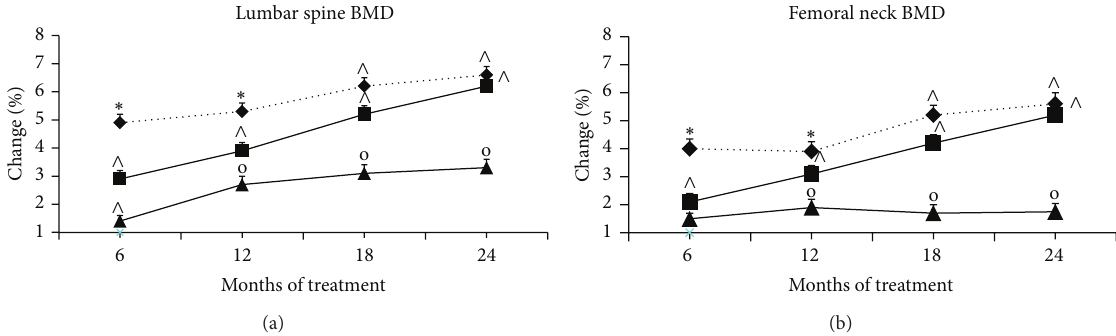
Figure 1: Changes in lumbar spine and femoral neck BMD throughout 24 months of treatment. Note: data are means ± SD. BMD: bone mineral density; ∗ : 𝑃 < 0.05 versus baseline, groups B and C; ∧ : 𝑃 < 0.05 versus baseline and group C. ⧫ : group A, the standard-dose TU group; ◼ : group B, the low-dose TU group; 󳵳 : group C, placebo